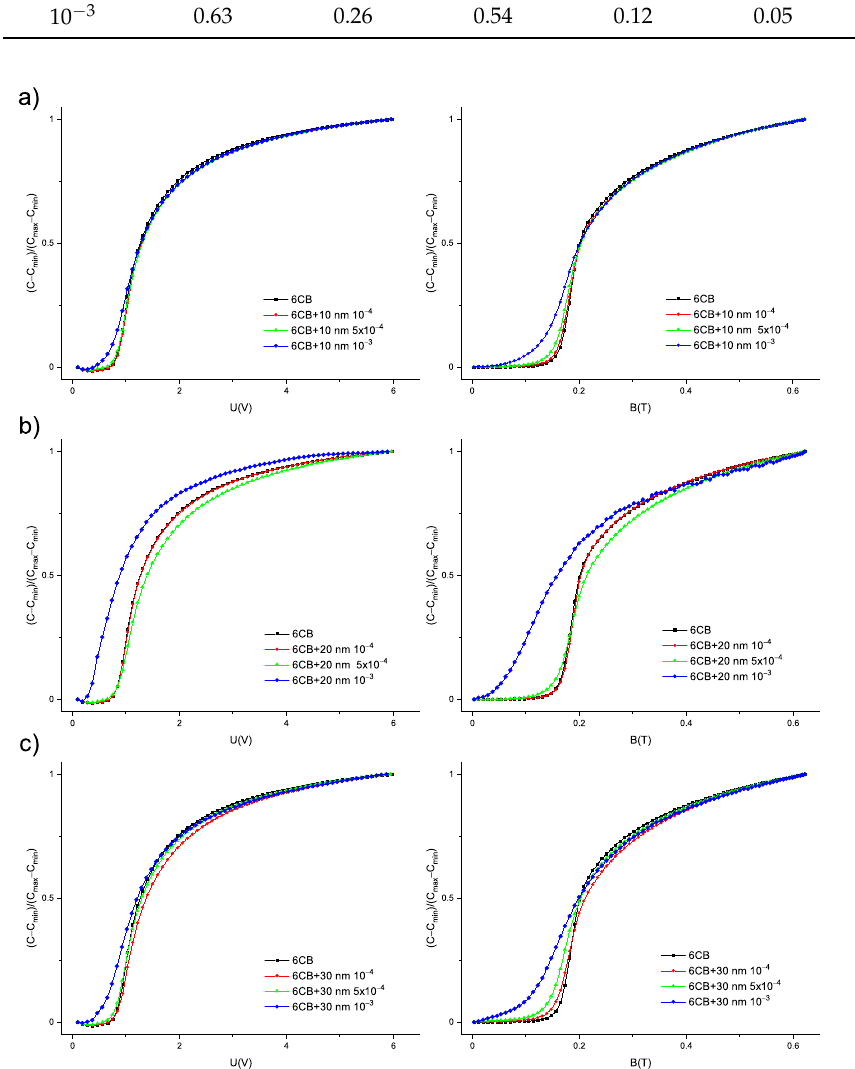
Figure 5. Dependencies of reduced capacitance on electric and magnetic field for pure 6CB and composites containing ( a ) 10 nm ( b ) 20 nm ( c ) 30 nm